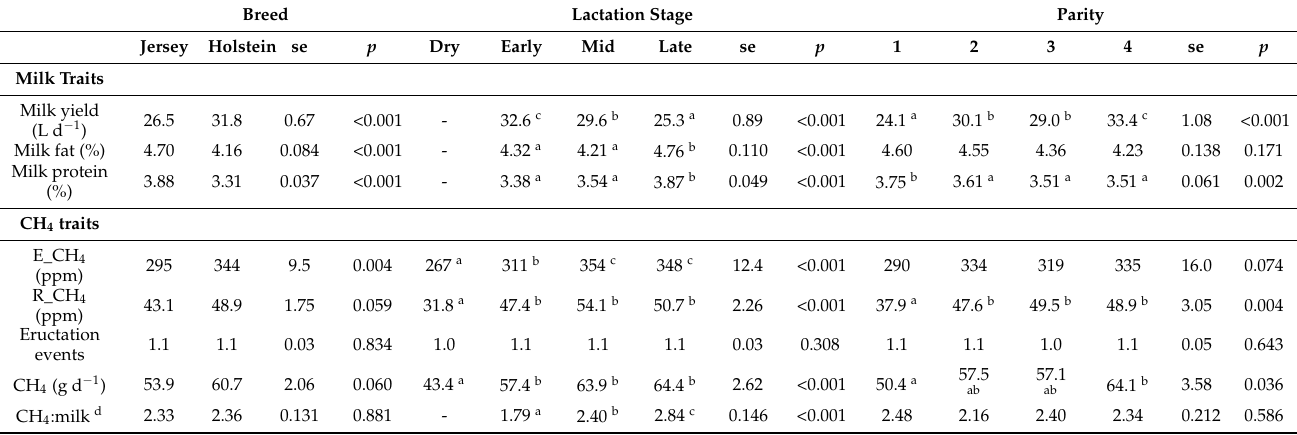
Table 2. Least squares means and standard error (se) of milk and CH 4 traits, according to breed, lactation stage, and parity of the 460